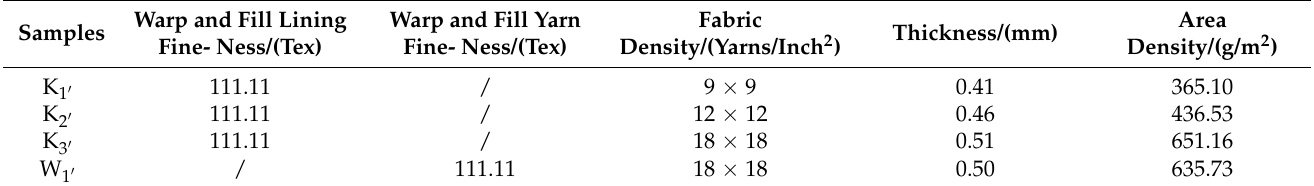
Table 1. The specifications of